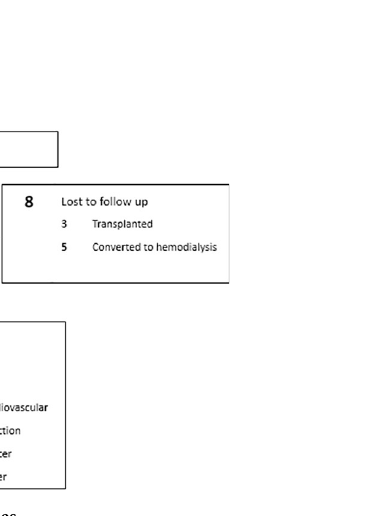
Fig 1. Flow diagram of subjects’ inclusion and their